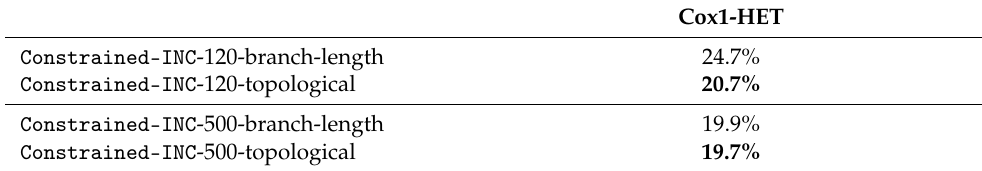
Table A4. Experiment 1: Impact on Constrained-INC tree error of subset size and distance ma- trix calculation on the Cox1-HET datasets. Here we show the tree error (FN) rates of running the Constrained-INC pipelines (IQ-TREE used for the starting and guide tree, as well as for the constraint trees) for different maximum subset sizes (120 or 500) and distance matrix calculation (topological vs. branch-length distances) on the guide tree using IQ-TREE. The results are averaged over 10 replicates. The most accurate result for each maximum subset size is boldfaced.